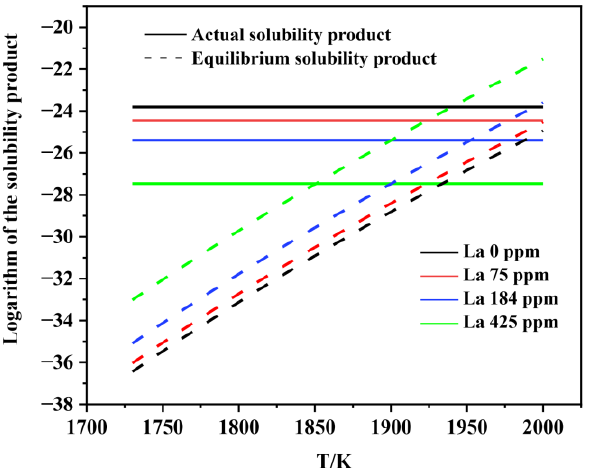
Figure 6. Logarithm of the solubility product as a function of temperature for Al 2 O 3 in liquid steel.